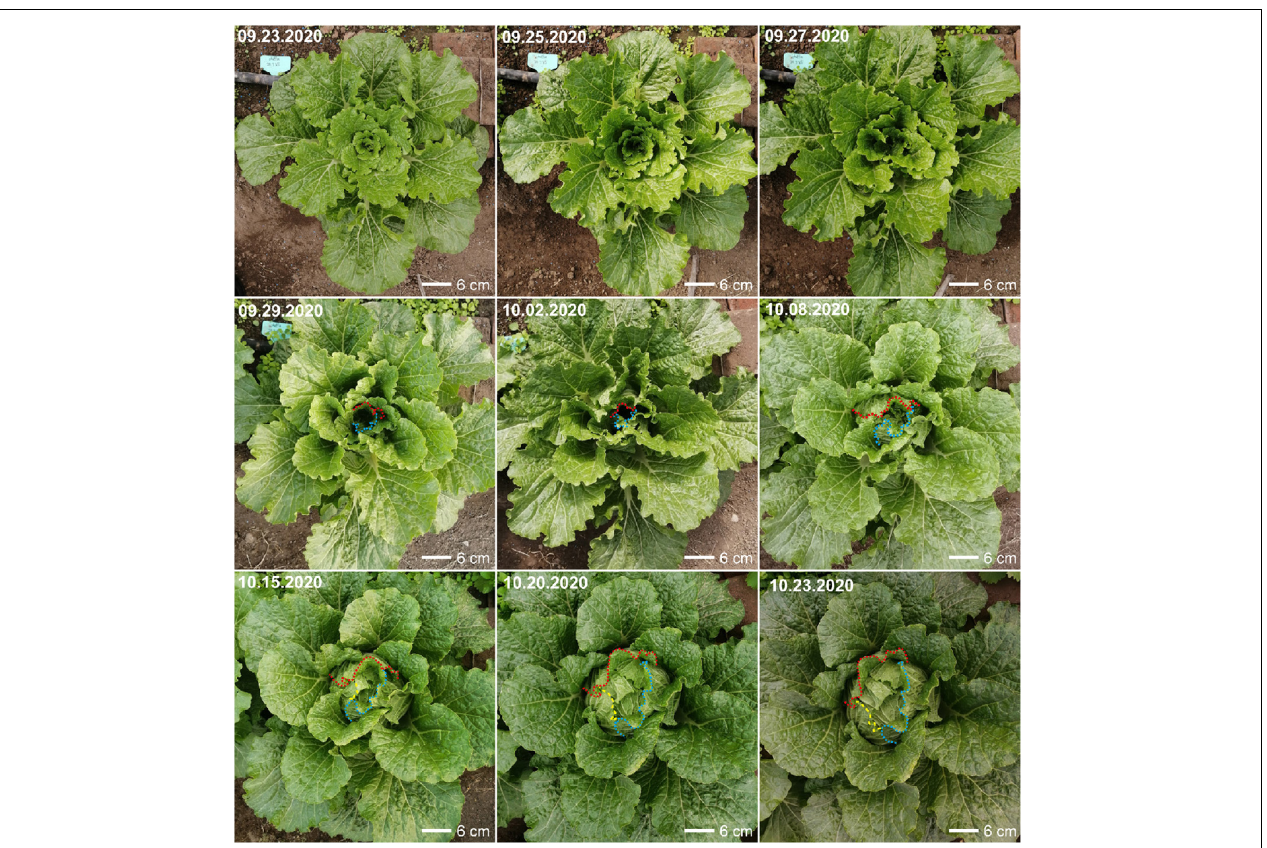
FIGURE 8 | Morphological changes of Chinese cabbage ( Brassica rapa cv Chiifu-401-42) from rosette stage to heading stage. The edges of key transition leaves were marked by colored dotted